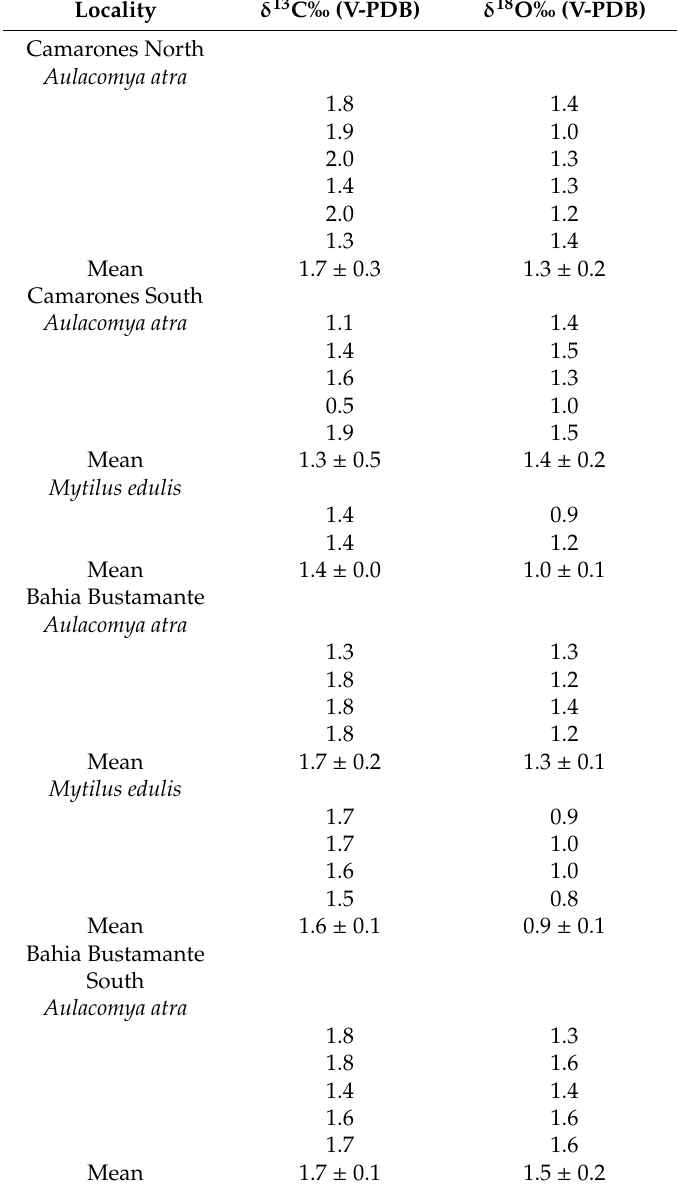
Table 2. Stable isotope composition (oxygen and carbon) of modern samples collected along the S. Jorge Gulf (see Figure 1b for